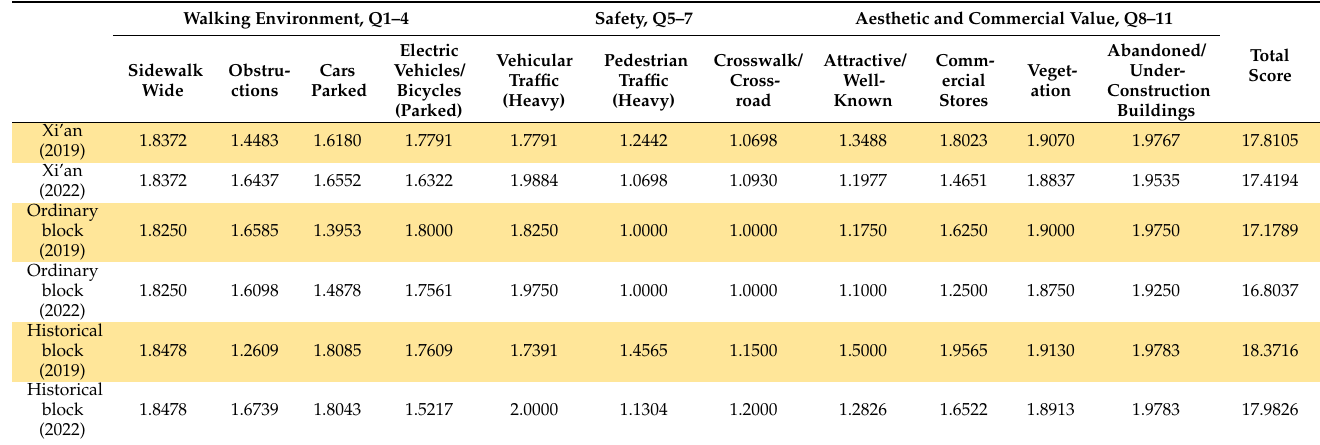
Table 2. Average Scores of Walkability